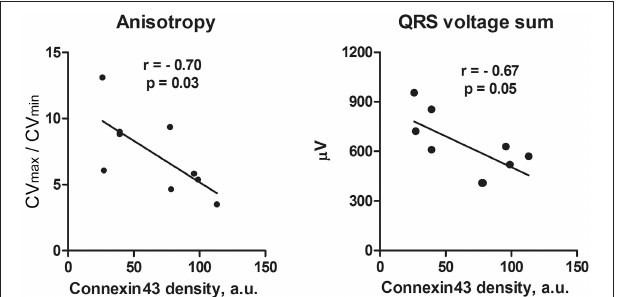
FIGURE 4 | Correlation analysis of anisotropy of conduction (A) and QRS voltage (B) with connexin43 amount in the ACF rats. With decreasing connexin43 expression that represents increasing phenotypic severity within the ACF group, there is an increase in conduction anisotropy and amplitude of QRS voltage. N = 9 samples from the ACF group (3 for each sub-group), r, Pearson’s correlation coefficient. Line represents linear regression.